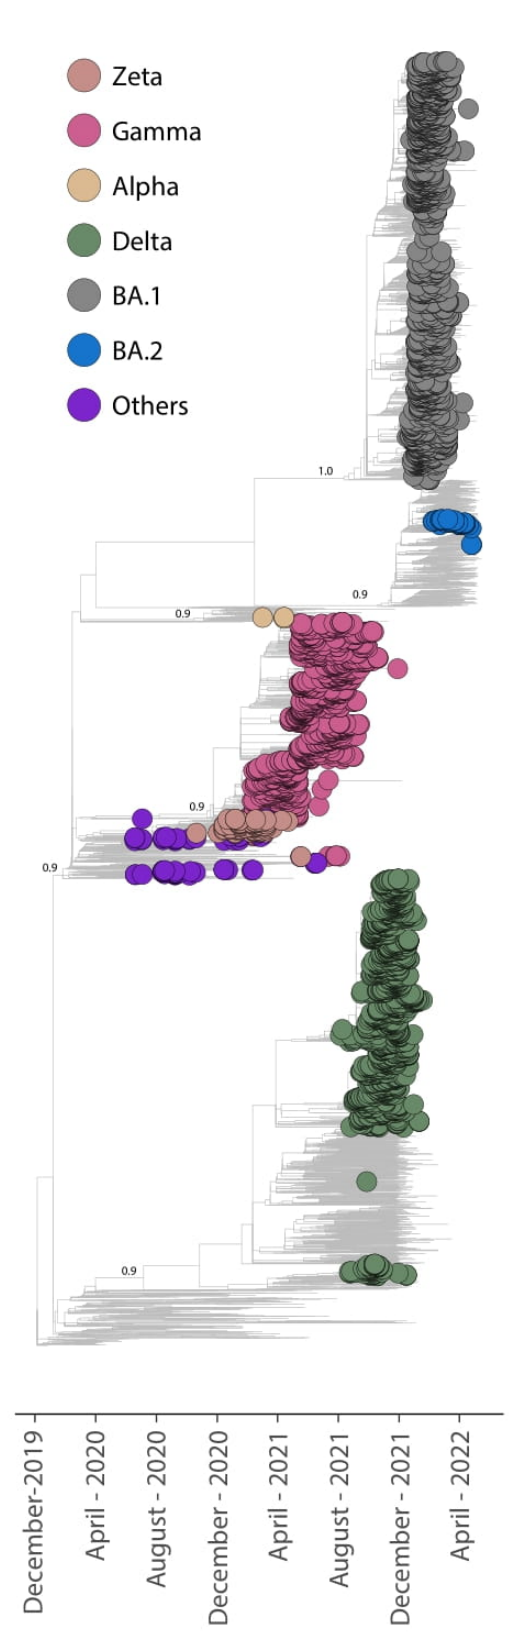
Figure 7. Time-resolved maximum likelihood tree containing (n = 4375) high-quality complete genome sequences from Serrana obtained in this study analyzed against a backdrop of global reference sequences. The samples obtained in this study are highlighted on the phylogenetic tree.